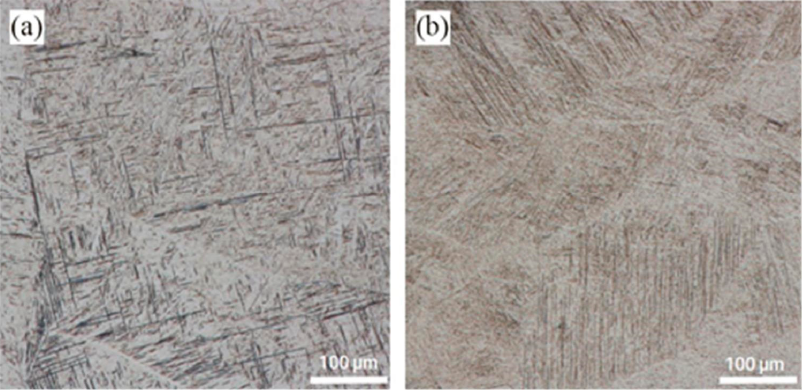
Figure 15. The microstructure of the fusion zones; ( a ) the underwater weld metal; ( b ) the in-air weld metal.